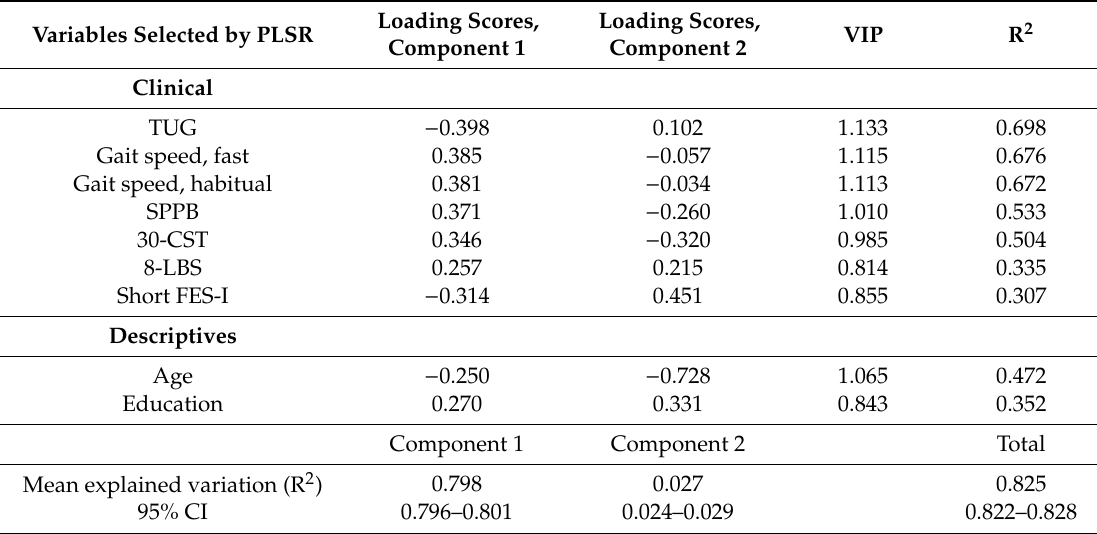
Table 3. Loading scores, R 2 and VIP scores for all variables selected and R 2 of the first two components in the PLSR analysis for standard clinical tests and descriptive